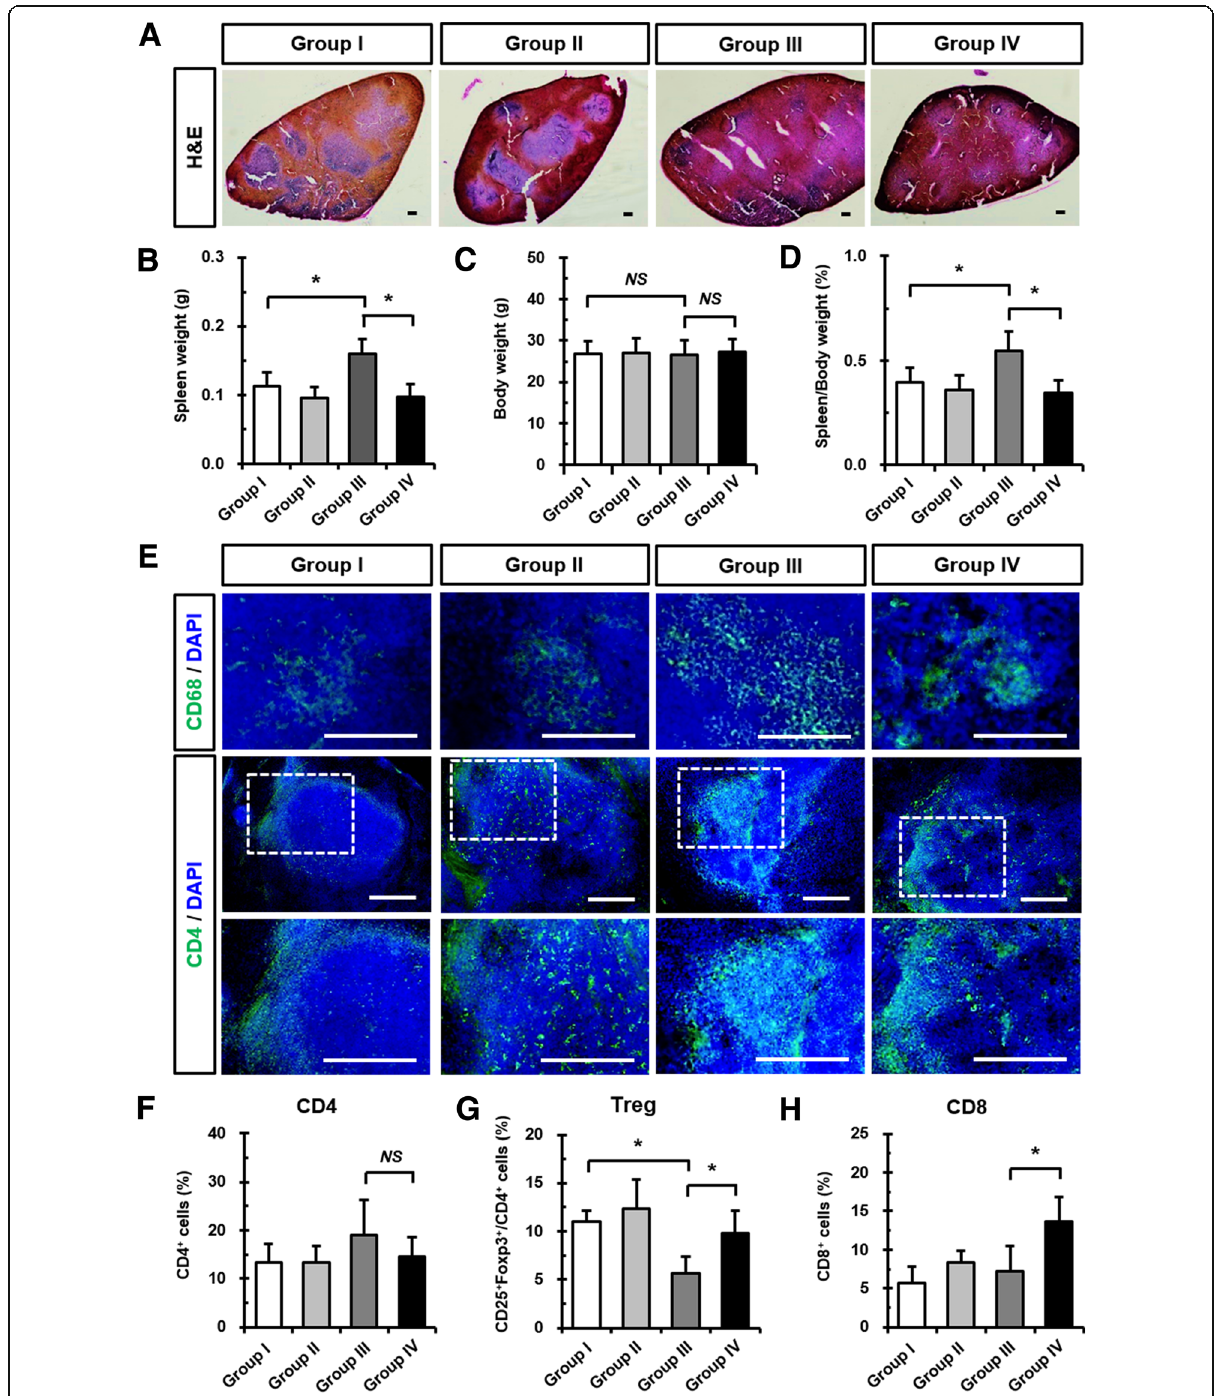
Fig. 4 Changes in Fimasartan on splenomegaly and immune cells in spleens after CA injury. a Representative H&E-stained images showing the size and distribution of splenic pulp at 28 days after CA injury and/or fimasartan administration. Scale bar: 100 μ m. b-d Quantitative analyses of relative spleen weight, body weight, and ratio of spleen weight/body weight were performed at 28 days after CA injury and/or fimasartan administration. e Representative immunofluorescence images showing CD68 + macrophages (green) and CD4 + T cells (green) expression in the spleen at 28 days after CA injury and/or fimasartan administration. Boxed regions were magnified in the under panels. Nuclei were stained with DAPI. Scale bar: 100 μ m. f-h Flow cytometry analyses of the number of CD4 + , Treg, and CD8 + T cells from spleen tissues at 28 days after CA injury and/or fimasartan administration. All experimental data are from n = 9, 10, 12, and 12 of ApoE KO mice in each group. The values are presented as the mean ± SD. * p < 0.05. NS , not